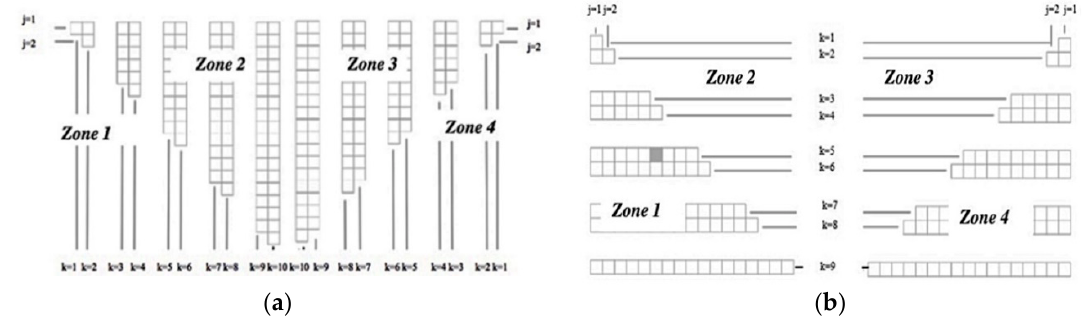
Figure 5. Nomenclature of the fishbone layout for zones 2 and 3 ( a ) and zones 1 and 4 ( b ).